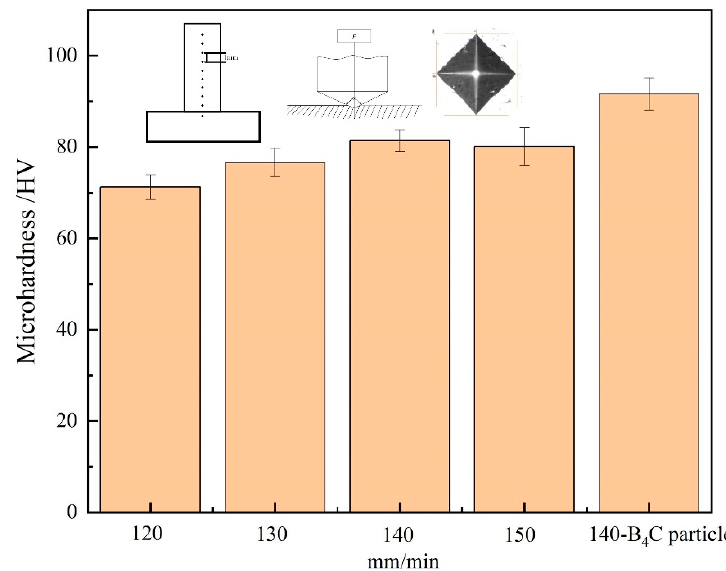
Figure 9. Microhardness values at different deposition rates with B 4 C powder.